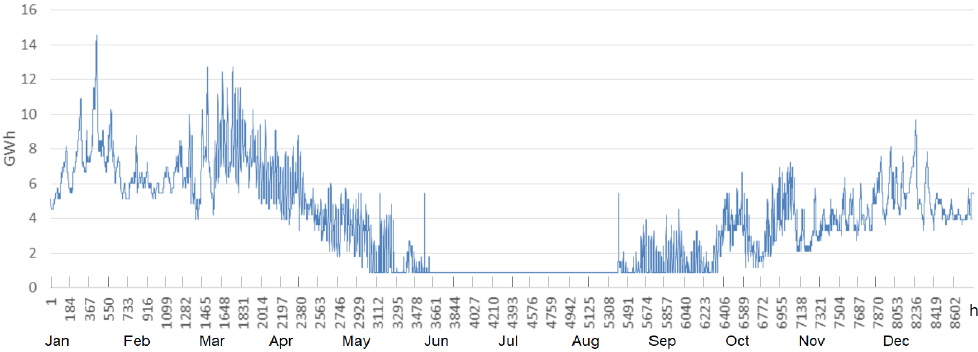
Figure 14. Hourly heat demand distribution in Finland.